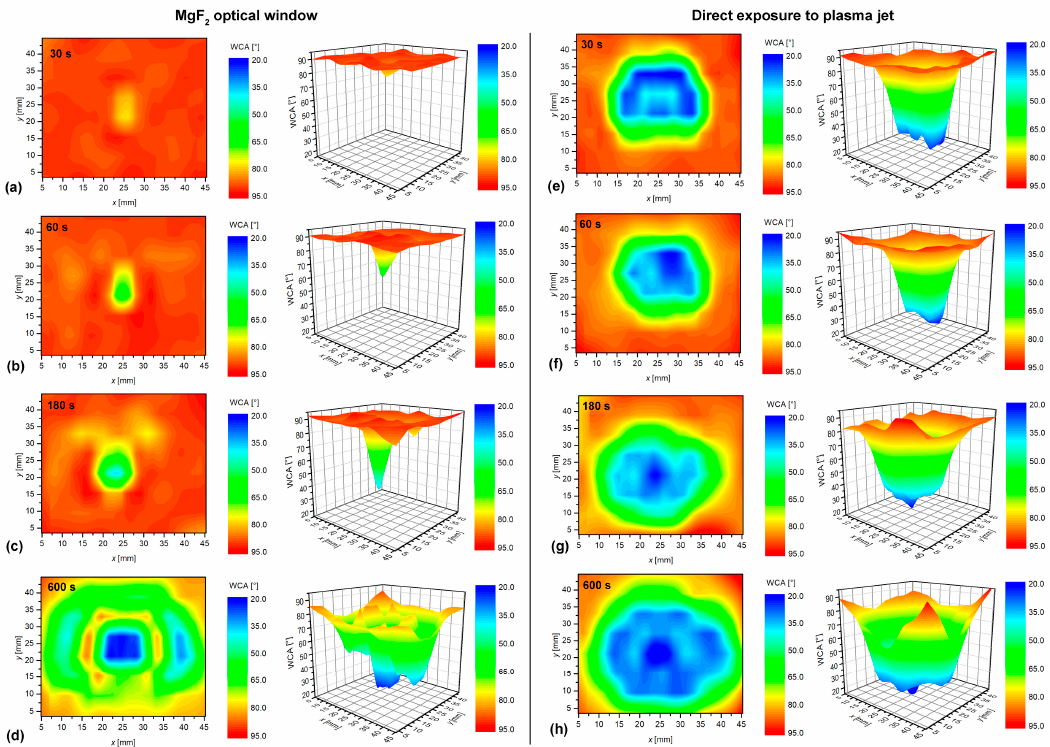
Figure 2. 2D and 3D images of surface wettability of polystyrene (PS) samples treated for various treatment times 30, 60, 180, and 600 s: ( a ), ( b ), ( c ), and ( d ) images on the left are for the case when samples were covered with MgF 2 window and thus exposed to VUV radiation only, whereas ( e ), ( f ), ( g ), and ( h ) images on the right are for the case of direct exposure to plasma (without any covering).